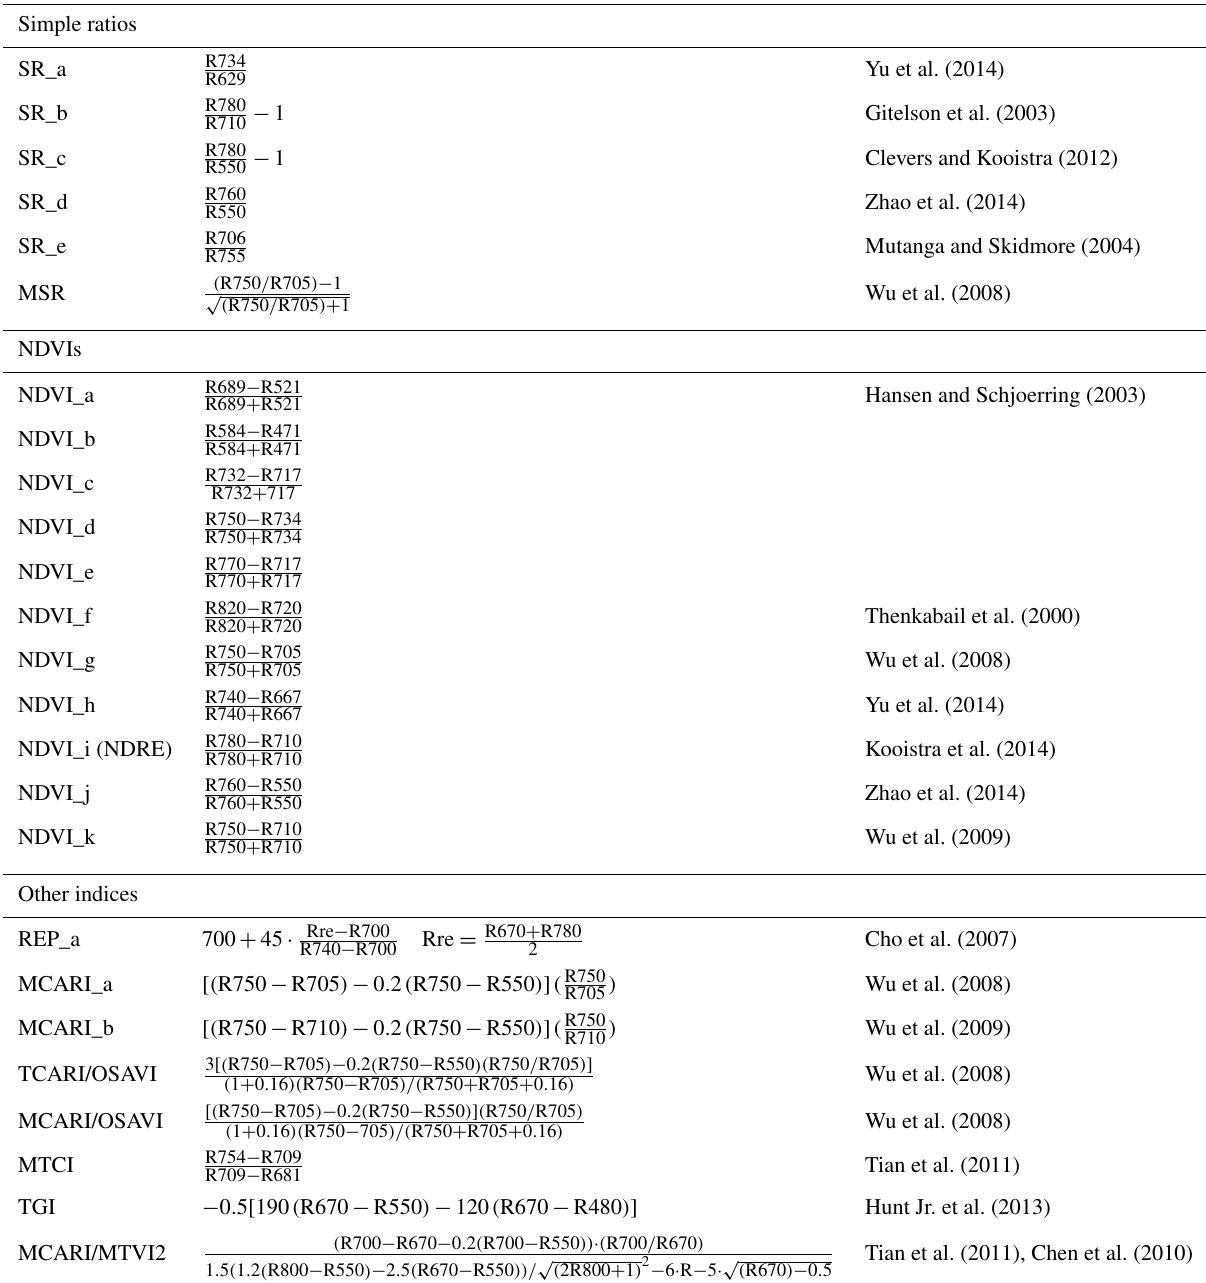
Table 1. Overview of existing vegetation indices that were evaluated in this study for retrieving plant traits from optical remote sensing images. A division is made in two-band indices based on simple ratios and NDVI, and other indices using more than two bands. The index description includes their formulation and the original